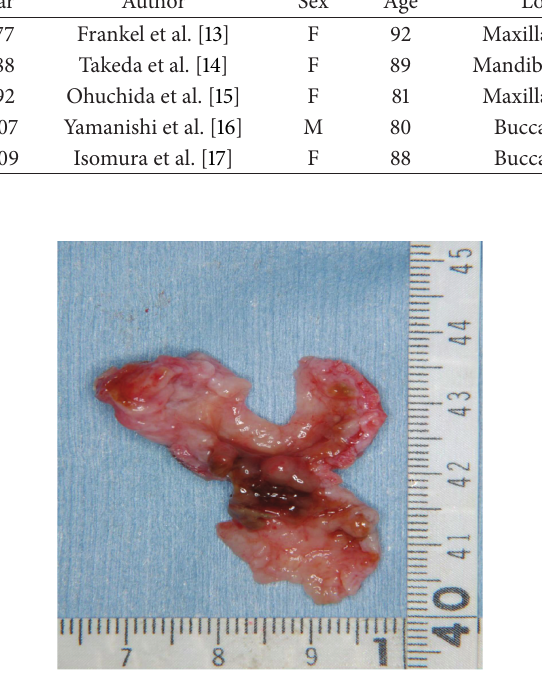
Figure 4: The excised tumor. It was milky-white in colour, with a slightlyroughsurface.Thetransversesectionwaslargelycystoid,but solid portions were also observed.